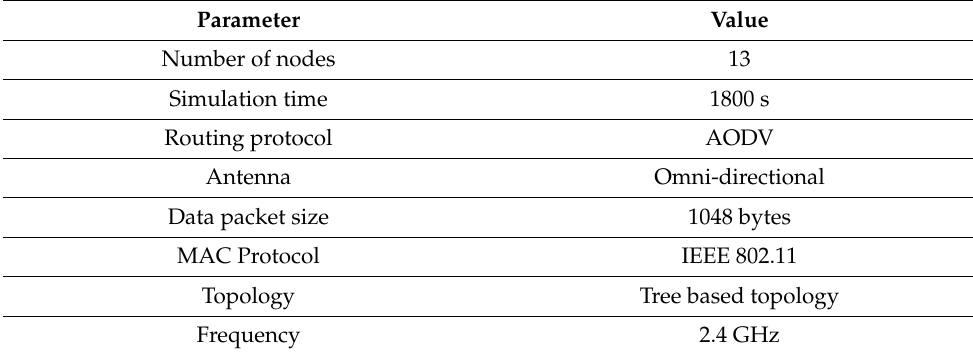
Figure 5. Routing topology used in DCCP. Table 2. Simulation